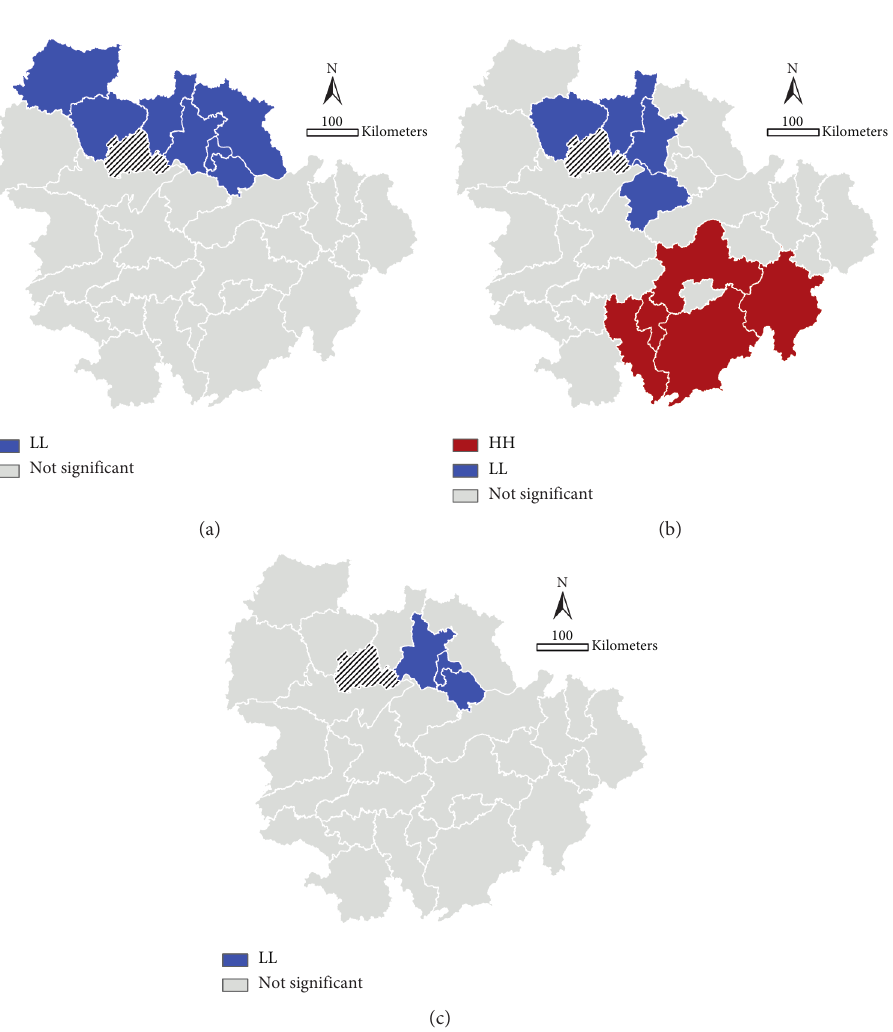
Figure 3: LISA clustering distribution of urban resilience: (a) Y 1; (b) Y 2; (c) Y